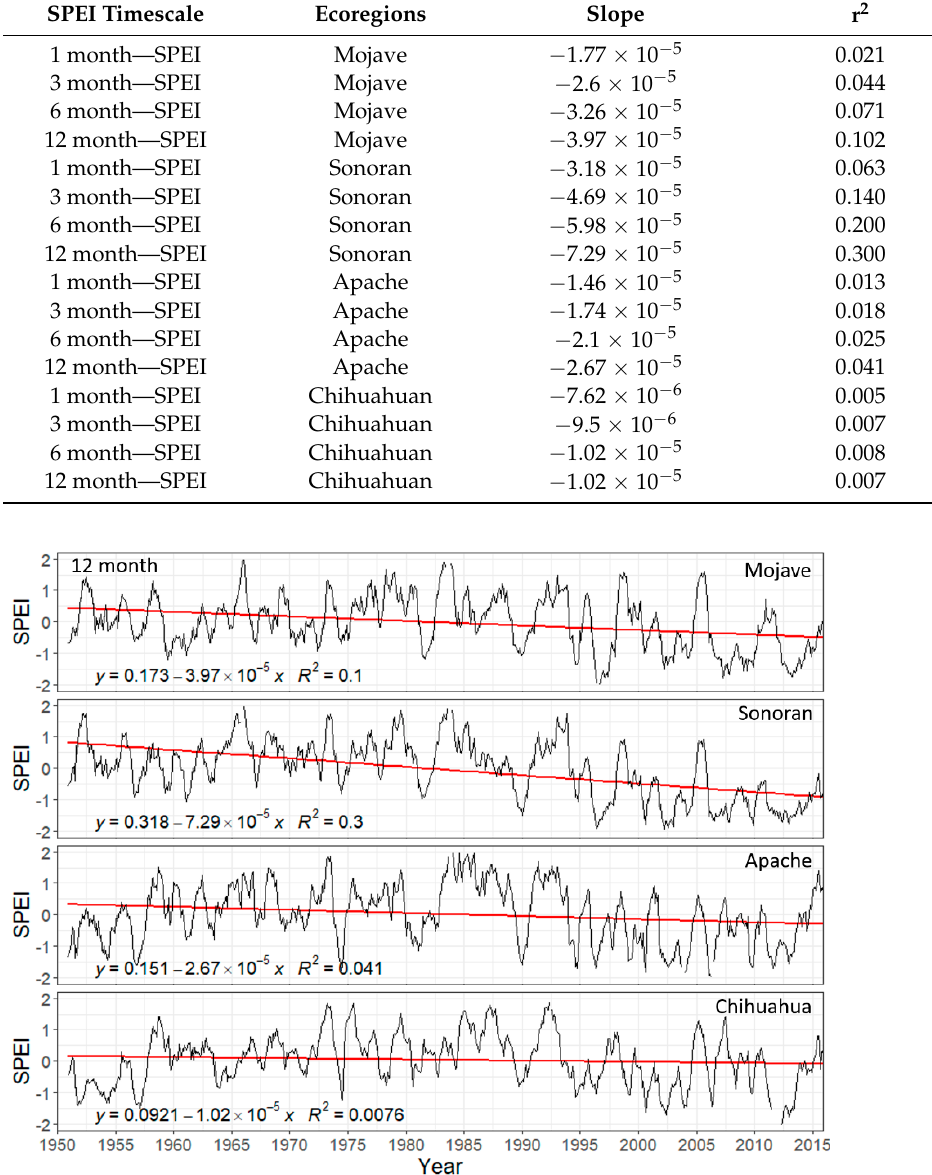
Figure 6. The number of months per year in which 12-month SPEI values indicated severe drought are shown for each year from 1950 to 2015 for all four ecoregions. The recent years focused on this Scheme 2000. had more severe drought compared to the preceding 50 years [31]. There is no classification for the SPEI values in the U.S. Drought Monitor. There- fore, similar to Barnes et al. [7] we used the drought severity classification of Standardized Precipitation Index (SPI) to classify SPEI used by U.S. Drought Monitor (https://droughtmonitor.unl.edu/About/AbouttheData/DroughtClassifica- tion.aspx (accessed on14 March 2021)).